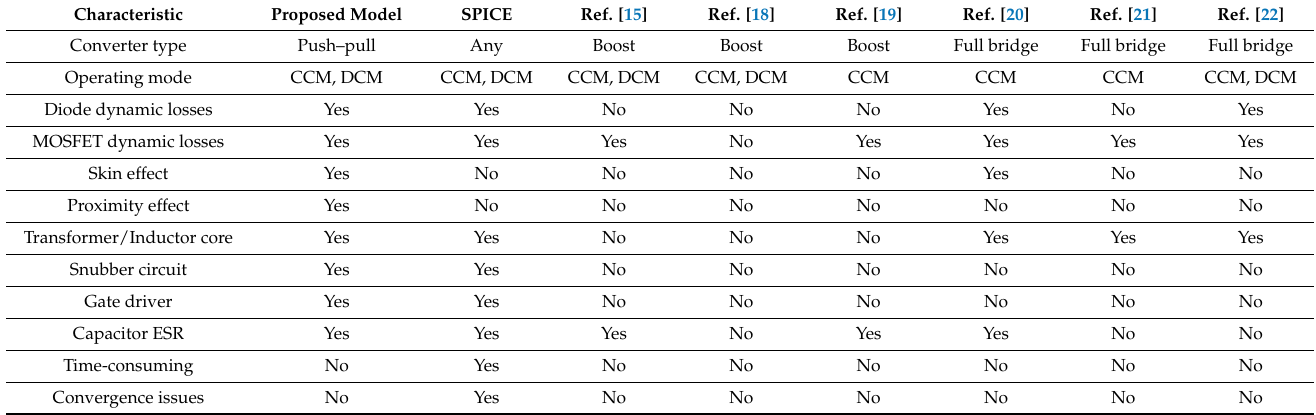
Table 1. Comparison of power losses